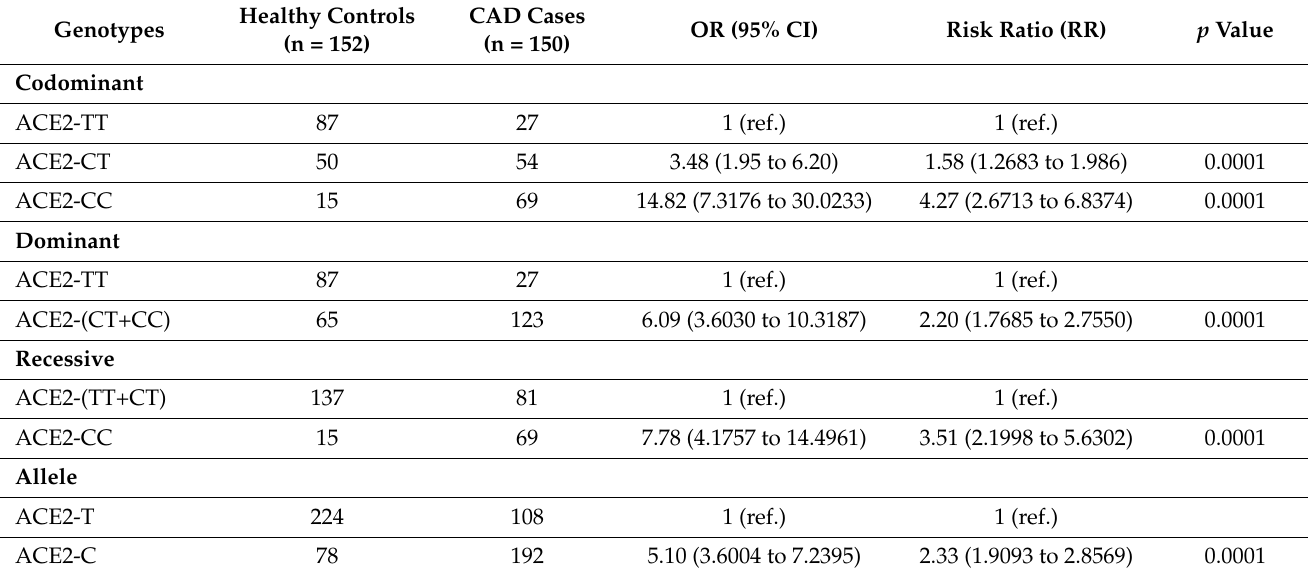
Table 7. Multivariate analysis of ACE2 rs4240157T>C gene polymorphism with coronary artery disease